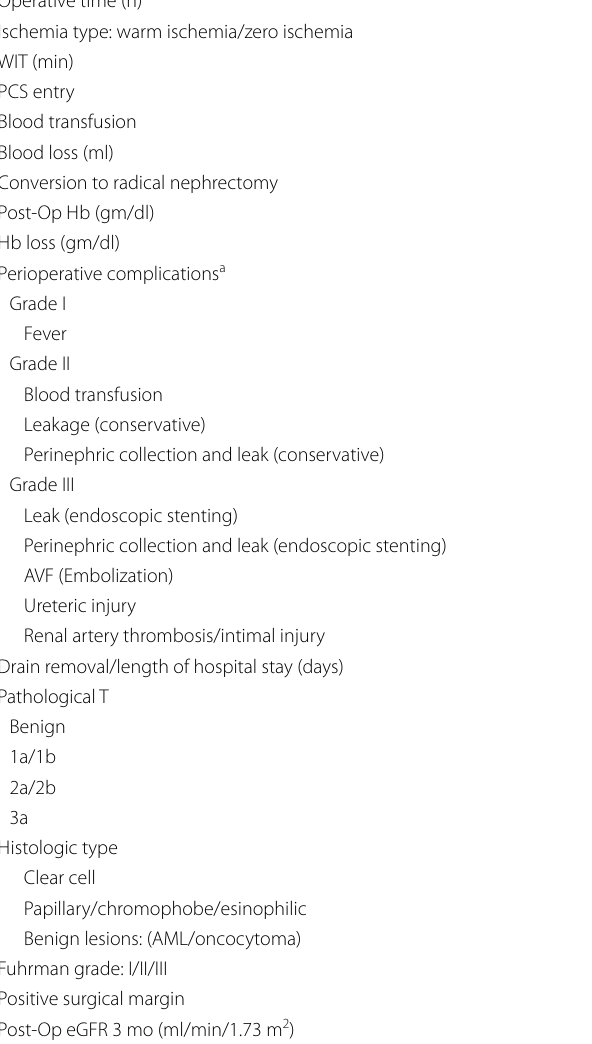
Table 2 Perioperative data, complications and follow-up Operative time